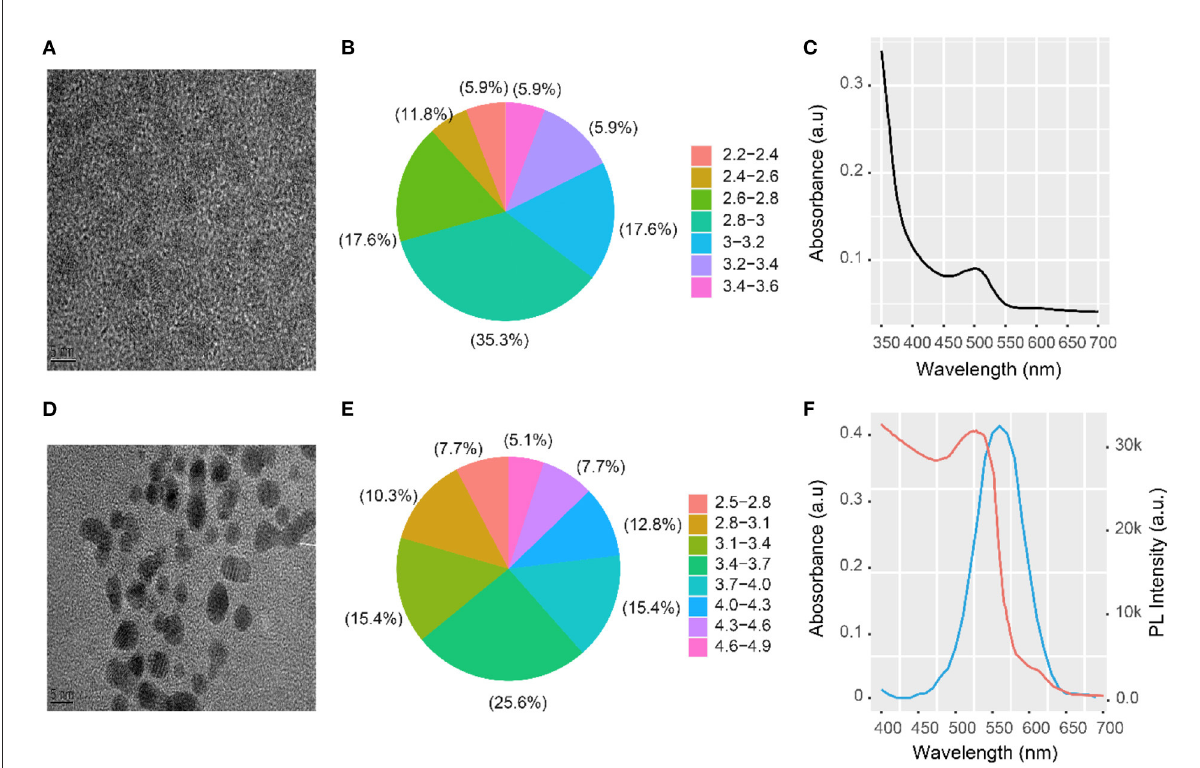
FIGURE1 HRTEM image and UV-vis absorption spectrum of CdTeQDs and AuNPs. (A) HRTEM image, (B) size distribution, and (C) UV-vis absorption spectrum of CdTe QDs; (D) HRTEM image and (E) size distribution of AuNPs; (F) PL emission spectrum of CdTe QDs (blue curve) and absorption spectrum of the AuNPs (red curve) along with UV-vis absorption spectrum of CdTe QDs.